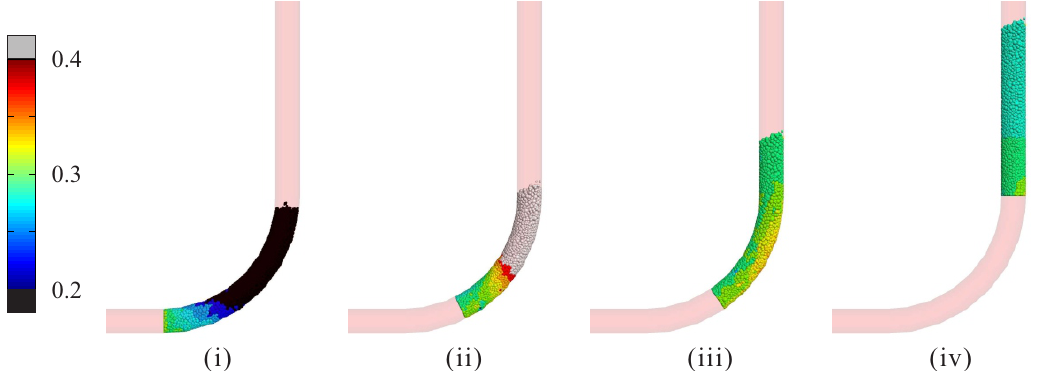
Figure 11. Simulation results with respect to the pipe diameter: plot of the velocity magnitude of particles at different states during the stable pumping stage for the case of d = 100